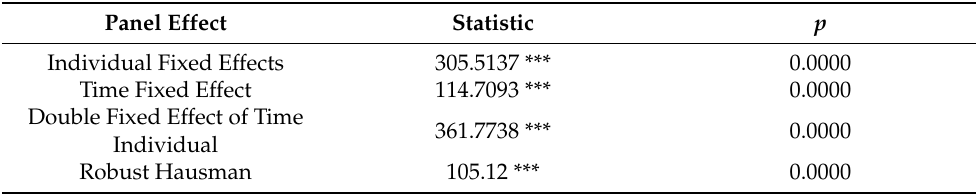
Table 9. The results of LR test and Hausman